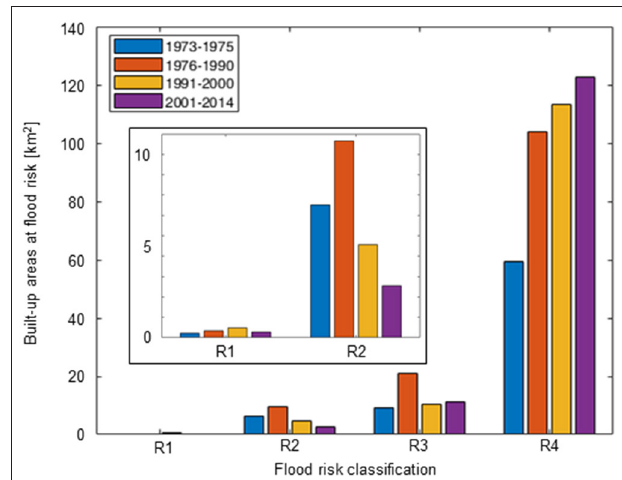
FIGURE 6 | Flood risk assessment, as categorized values derived from the percentile-based classification of flood hazard and exposure, across the MDB from 1973 to 2014: temporal evolution of the overall extension of built-up areas at risk in each flood risk class (in km 2 ), as defined in Figure 1 . The inset shows a zoom for classes R1 and